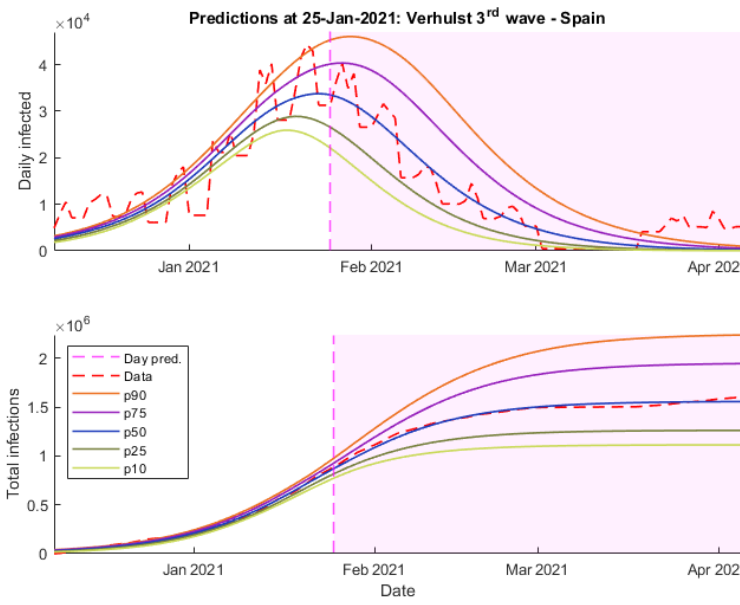
Figure 11. Predictions 25 January 2021 wave 3 Verhults — Spain.